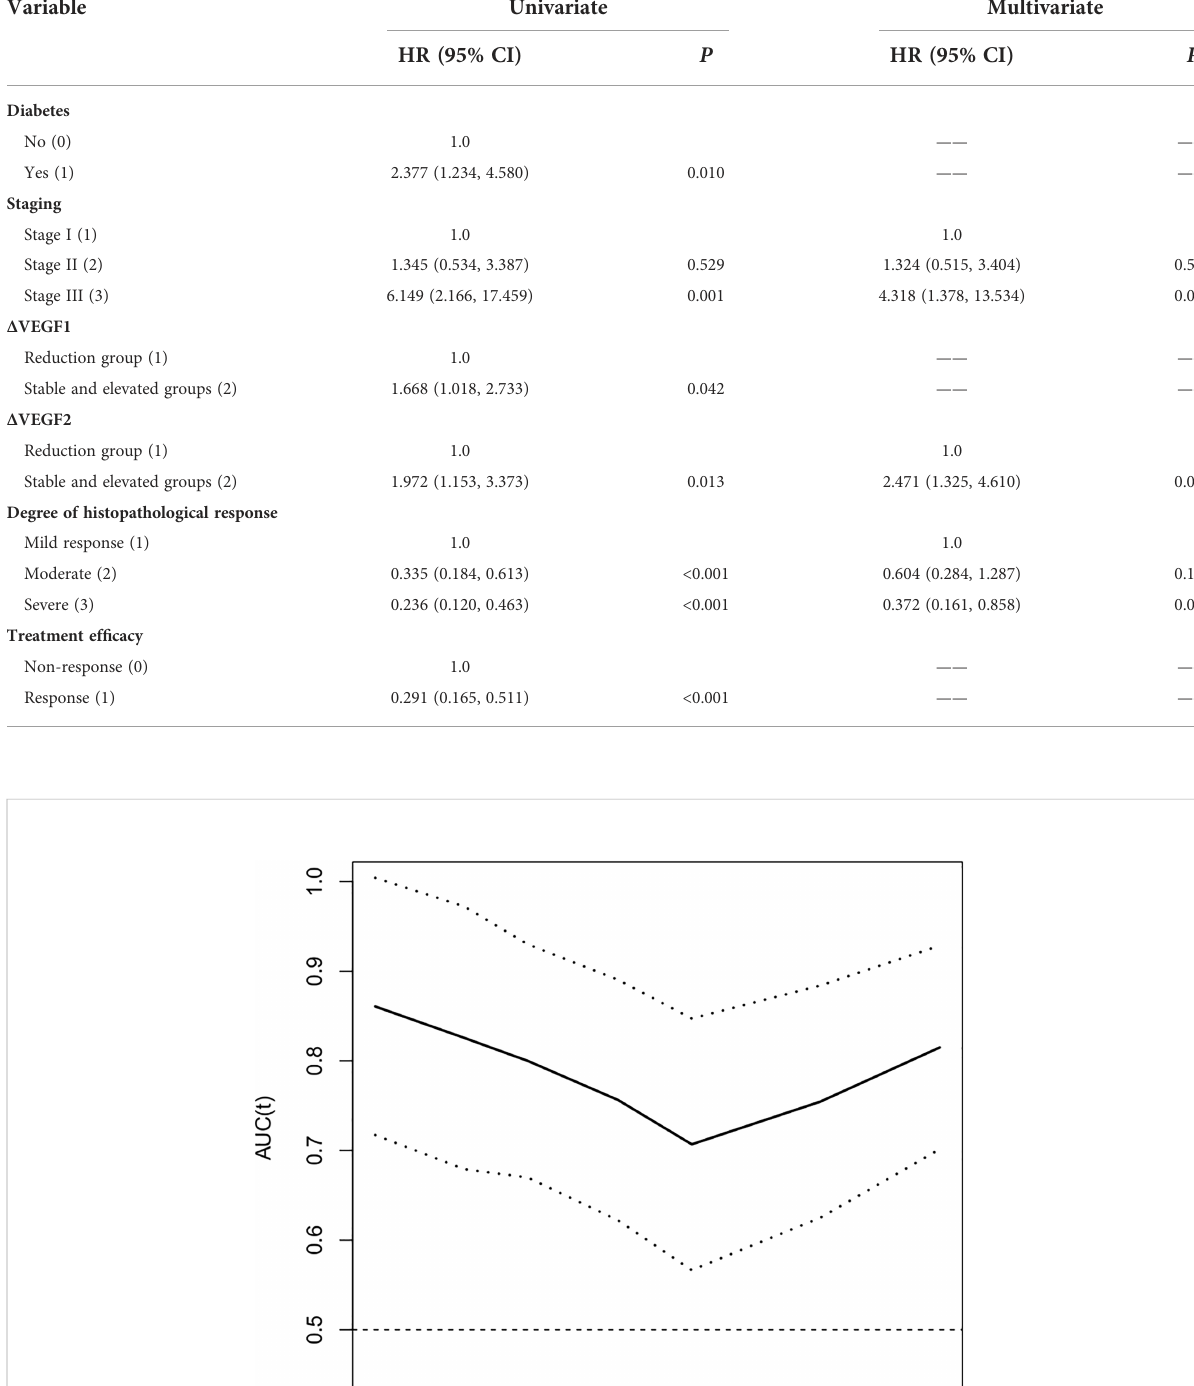
TABLE 6 Univariate and multivariate COX regression analysis of PFS in patients with non-surgical ESCC.